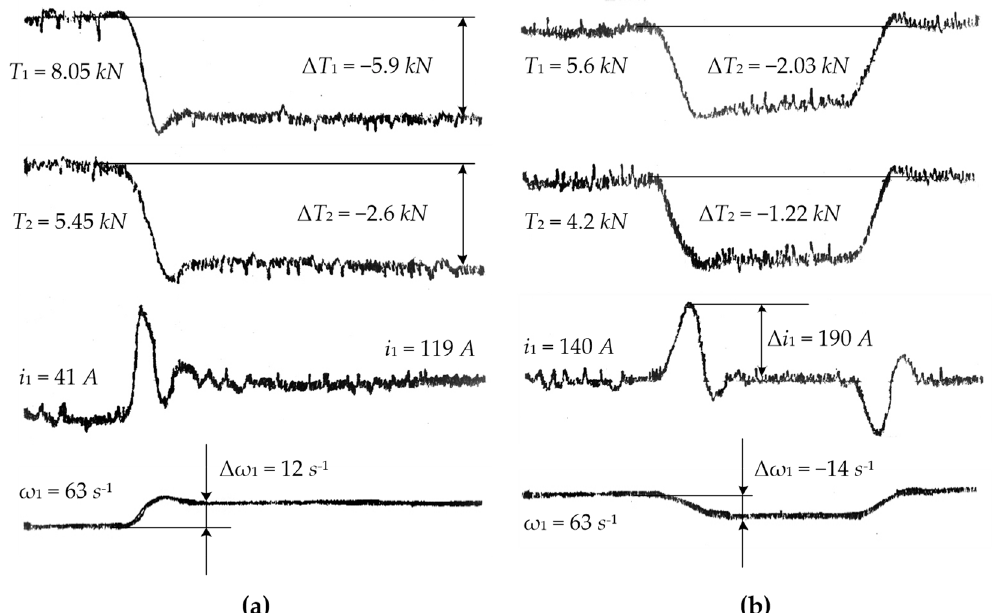
Figure 9. Transient Processes When Simulating a Change in The Semifinished Rolled Product Diameter in The Existing ( a ) & Developed ( b ) Control Systems.